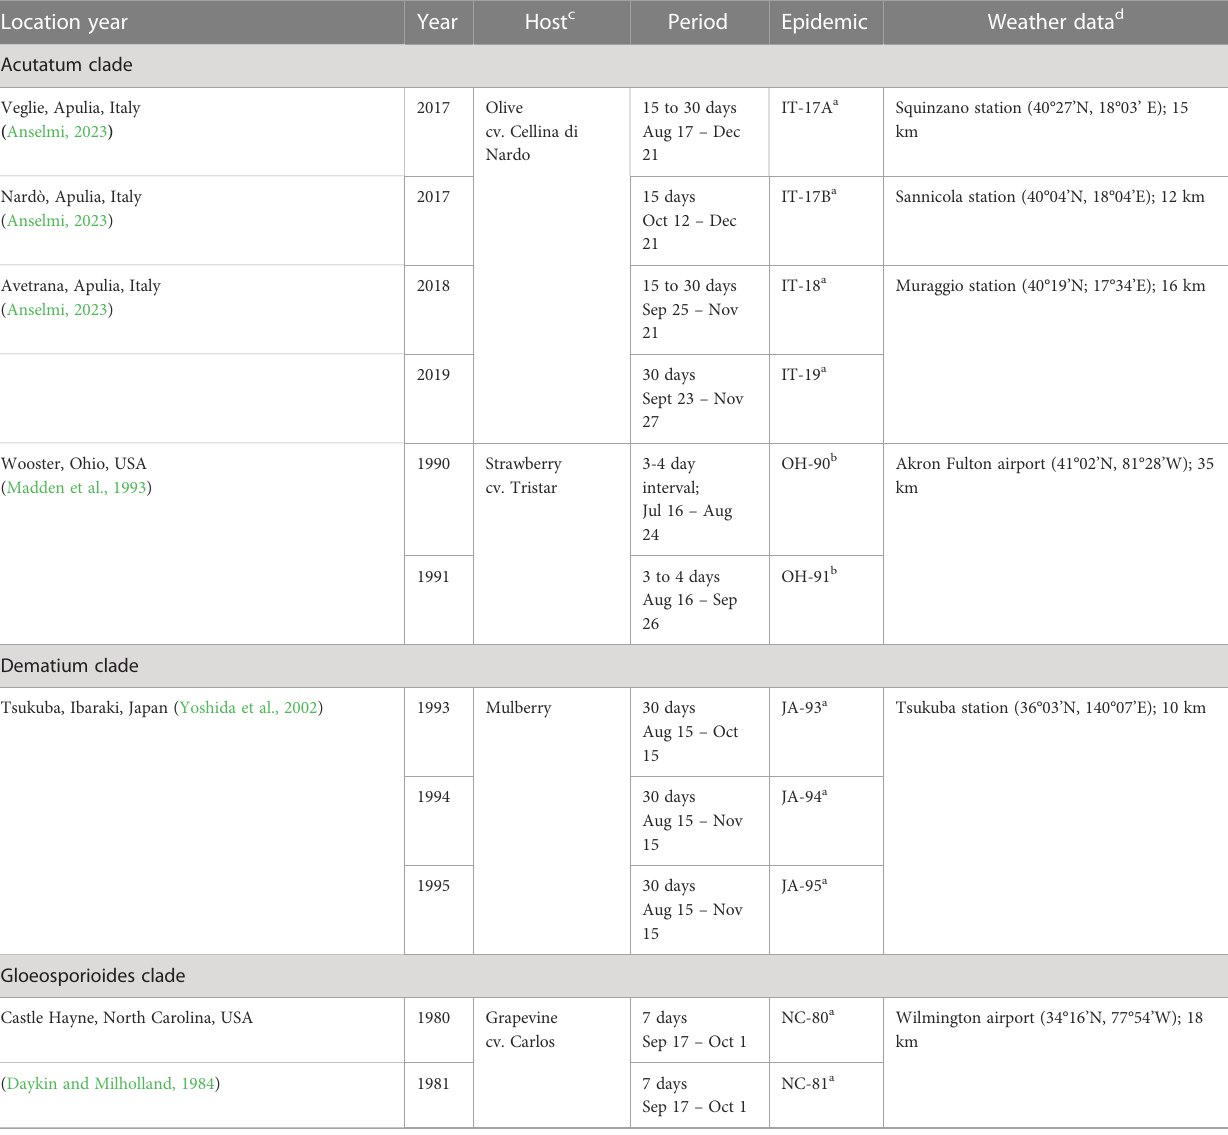
TABLE 2 Summary description of the 17 epidemics used for model evaluation and source of weather data used to operate the model. Location